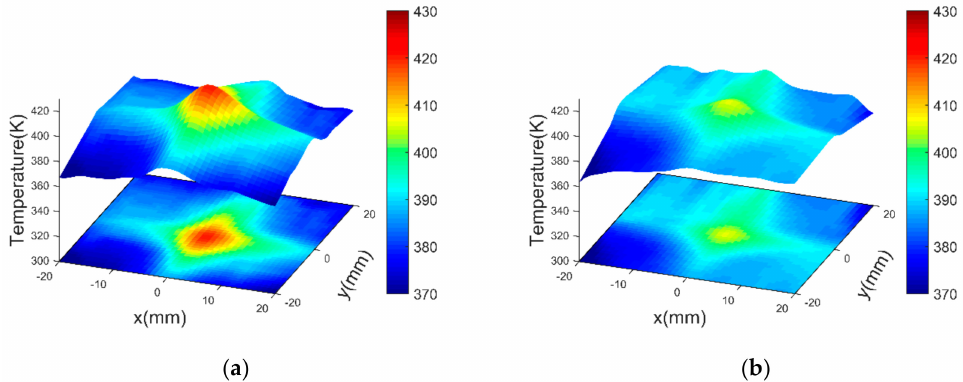
Figure 7. 2D reconstructed temperature distributions at the engine running time 5.0 s: ( a ) 51 cycles and ( b ) 201